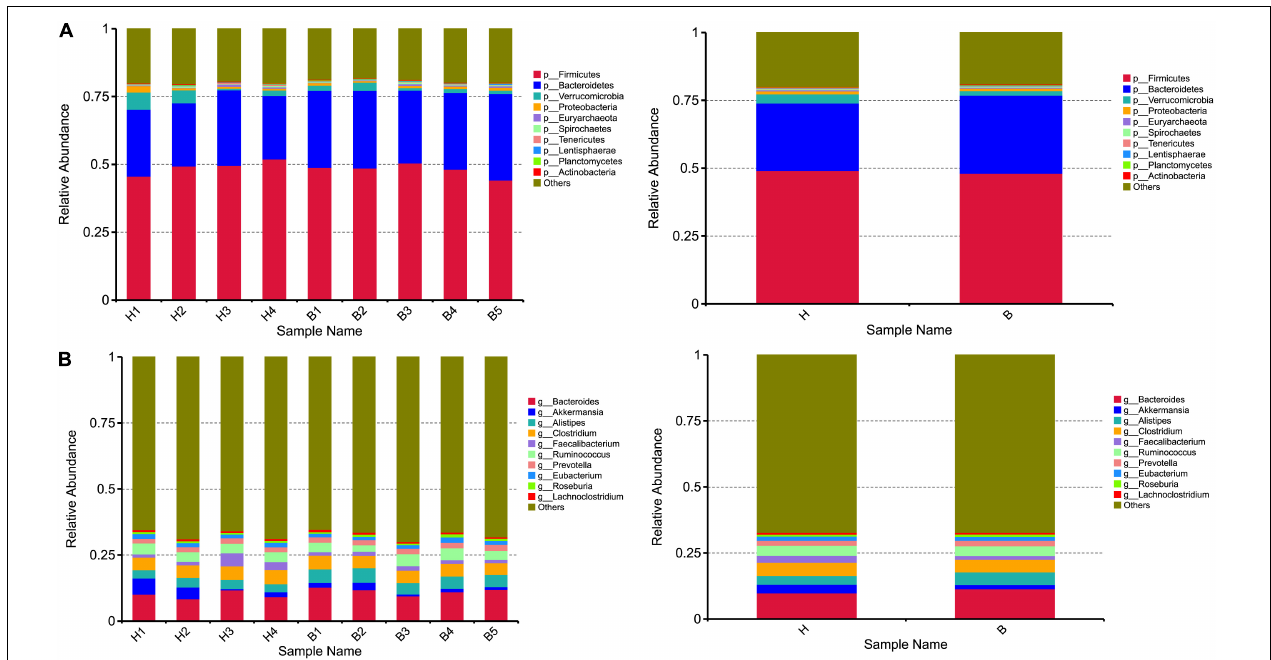
FIGURE 2 | Taxonomic composition of the gut microbiota communities on the (A) phylum and (B) genus levels. Each bar represents the 10 most abundant taxa.